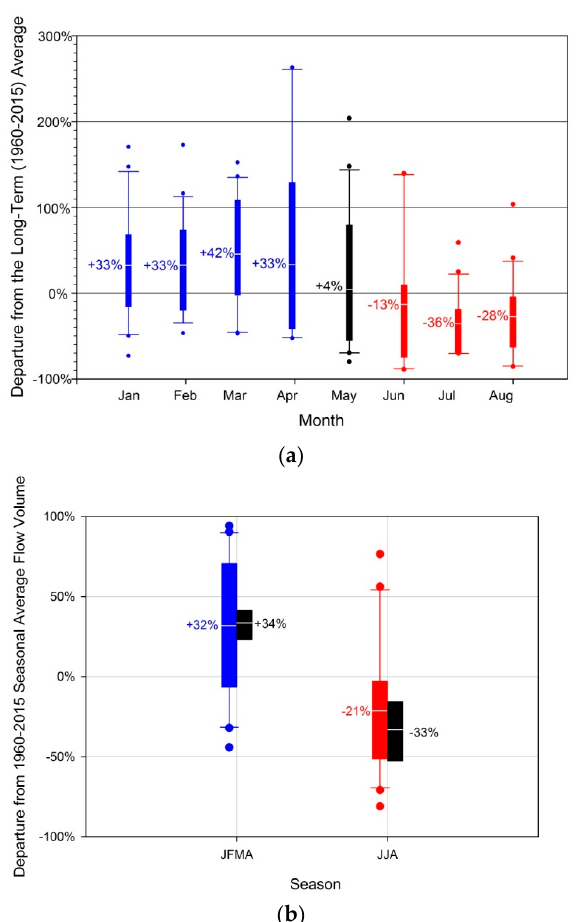
Figure 3. ( a ) Monthly departure (%) for post-El Niño year streamflow when compared to the long-term average for five gages in coastal MS-AL. ( b ) Seasonal (JFMA (blue) and JJA (red)) departure (%) for post-El Niño year streamflow when compared to the long-term average for five gages in coastal MS-AL and seasonal (JFMA (black) and JJA (black)) departure (%) for 2016 streamflow when compared to the historic long-term average for five gages in coastal MS-AL. The lower boundary of the solid box represents the 25th percentile while the upper boundary of the solid box represents the 75th percentile. The lower whisker represents the 10th percentile while the upper whisker represents the 90th percentile. Outliers are displayed as dots.